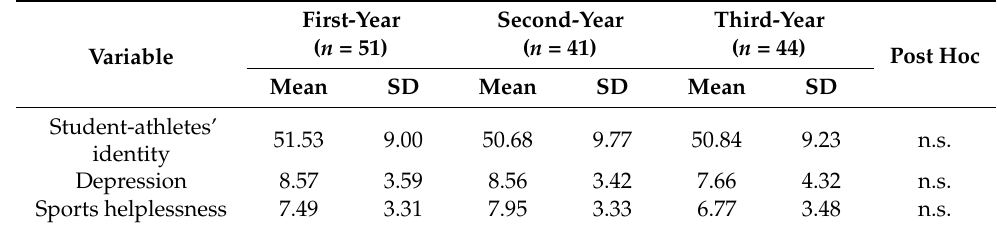
Table 2. Means (SD) and post hoc analysis for subscales between university year.